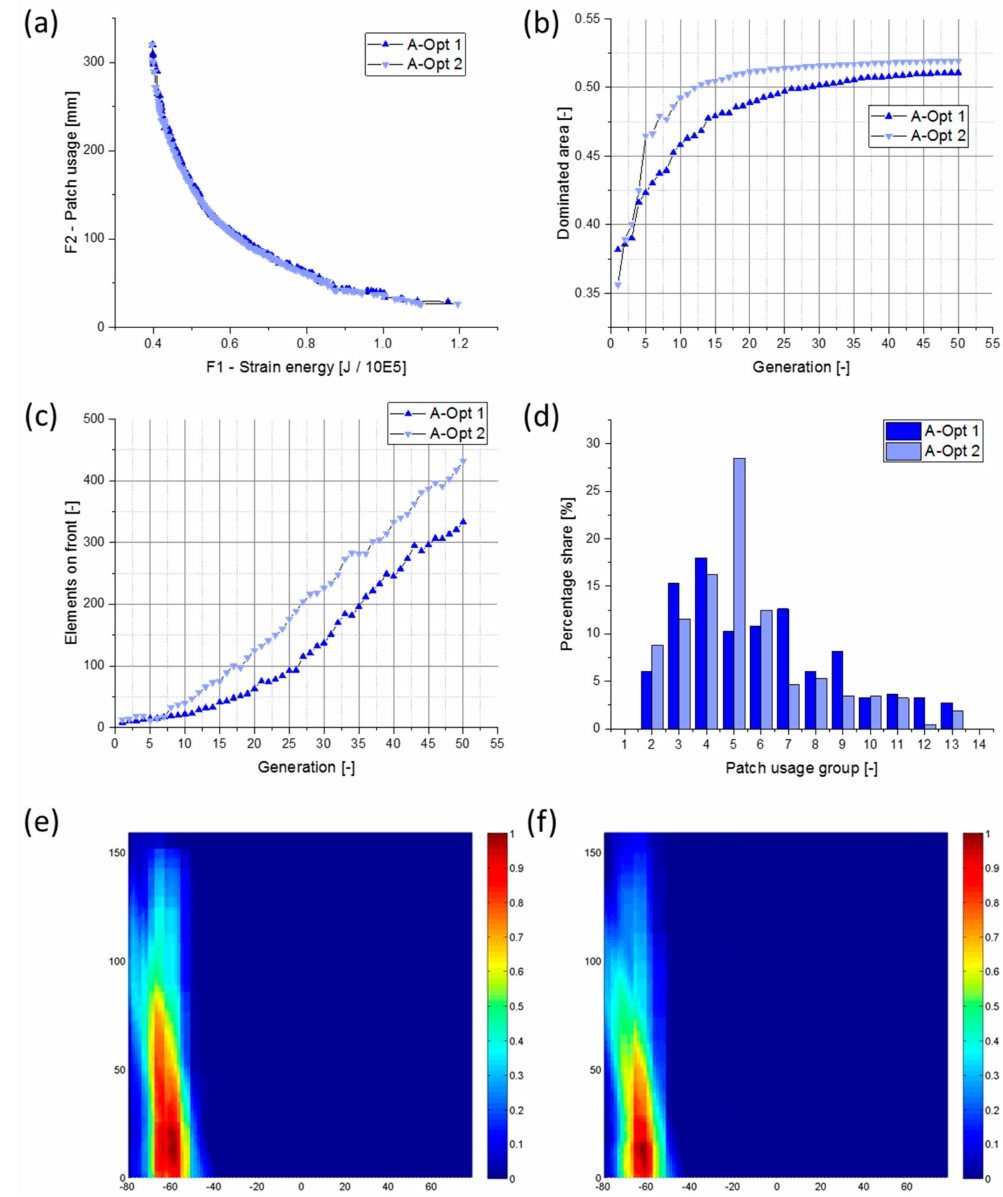
Figure 11. Comparison of the results of the two crossover processes A-Opt 1 (parameterized binary crossover) and A-Opt 2 (multi-point binary crossover): ( a ) Comparison of the final Pareto fronts, ( b ) the dominated area for the evaluation of the convergence behavior, ( c ) development of the number of elements on the current Pareto front for each generation, ( d ) percentage share of the solutions along the Pareto front (blue dots in ( a )) for each length-group with a step-length of 25 mm, ( e ) heat map for A-Opt 1, ( f ) heat map for A-Opt